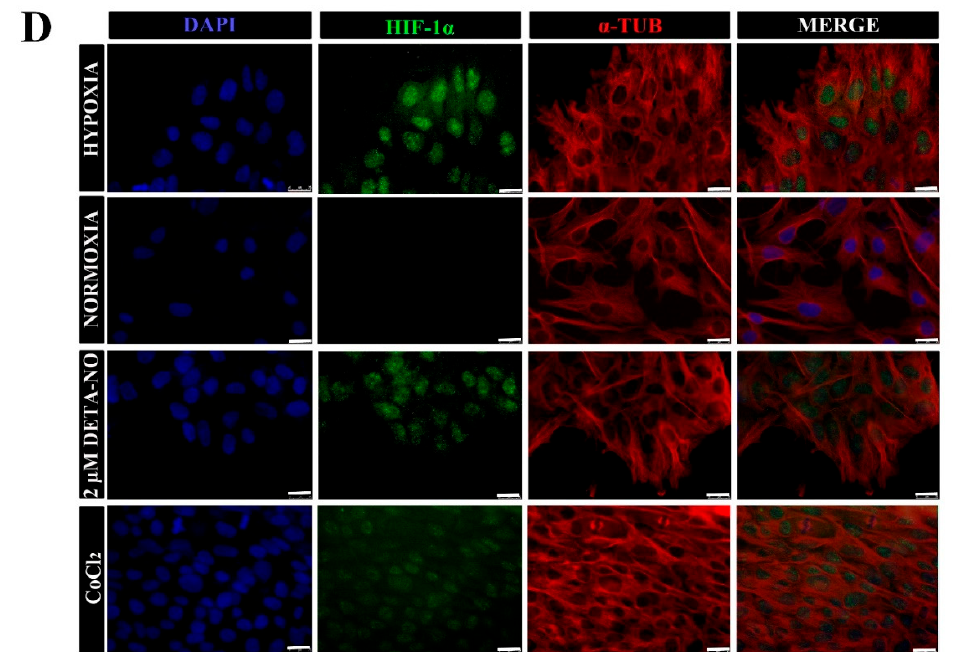
Figure 1. Low doses of DETA-NO induce the accumulation of HIF-1 α protein in human iPSCs cultured under normoxia. ( A ) Cells from the MSUH-001 line were cultured in fibroblast-conditioned human PSC culture medium and supplemented with 20% KSR and bFGF (8 ng/mL) for 6 days according to the culture protocols shown. ( B ) Analysis of HIF-1 α by flow cytometry. Cells were treated for 48 h with low doses of DETA-NO (2 µ M and 10 µ M) in normoxia and 48 h in 5% hypoxia O 2 . The intensity of the HIF-1 α fluorescent signal is plotted against the number of cells counted. Each plot is representative of 3 independent experiments. The isotype control and secondary antibody control that were depicted in gray were used as negative controls. The number of cells tested is at least 3000–5000 cells in each experimental condition. ( C ) Percentage of cells positive for HIF-1 α ± SEM of 3 independent experiments. ( D ) Immunocytochemical localization of HIF-1 α . Cells were labeled with DAPI (blue), anti-HIF-1 α (green), and anti- α -Tubulin (red). Scale bar: 25 µ m. The images shown are representative of 3 independent experiments and have been acquired with the Leica DM6000B fluorescence microscope (AF6000). (*) p < 0.05; (**) p < 0.0001. HIPX (HYPOXIA);